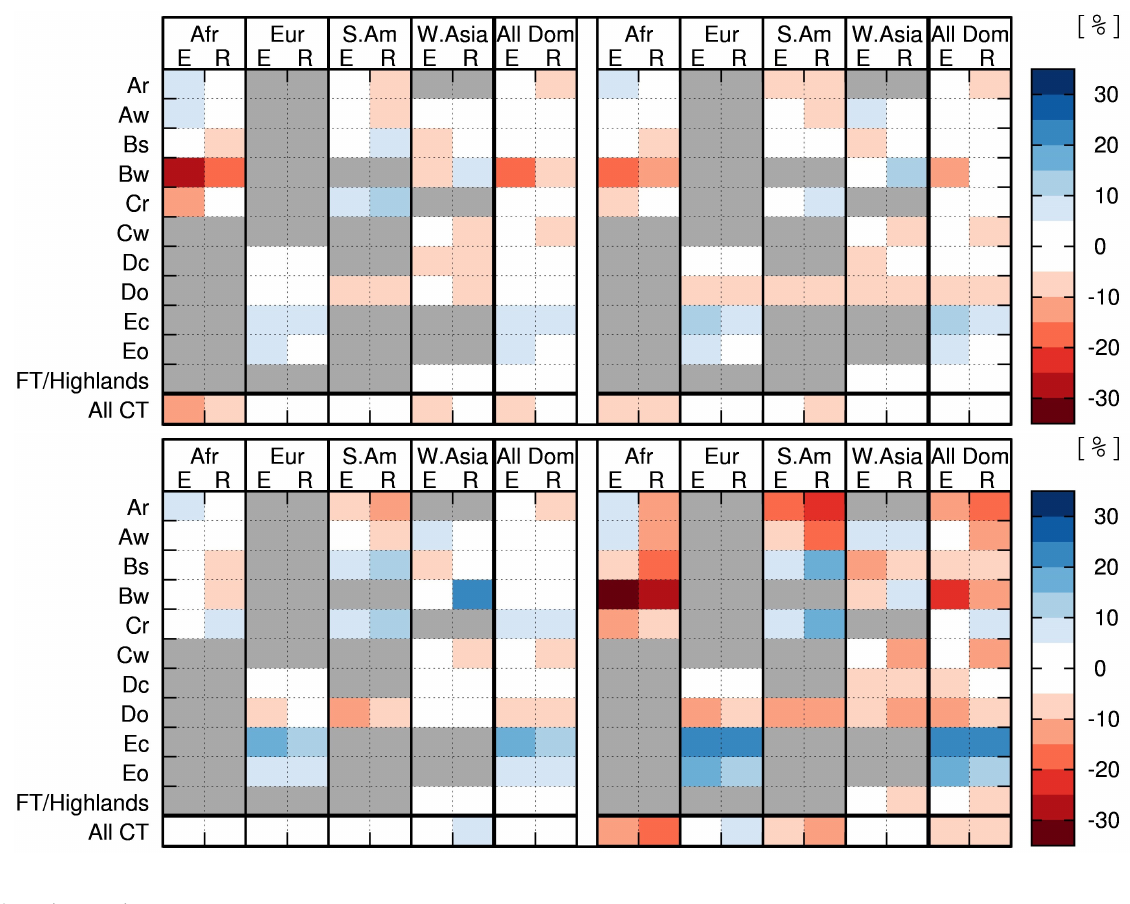
Climate change signals for each domain and each climate type for annual precipitation sums. The climate change signals are depicted for precipitation for RCP 4.5 (upper plot) and for RCP 8.5 (lower plot), considering only grid boxes for one specific climate type per region. Climate change signals as simulated by MPI-ESM (LR) (E) and REMO (R) are plotted on the left-hand side and on the ride-hand-side, respectively. The time periods considered are 2036–2065 (left panel) and 2071–2100 (right panel), compared to the time period 1971–2000. Climate types that are not present in the respective domain are depicted in